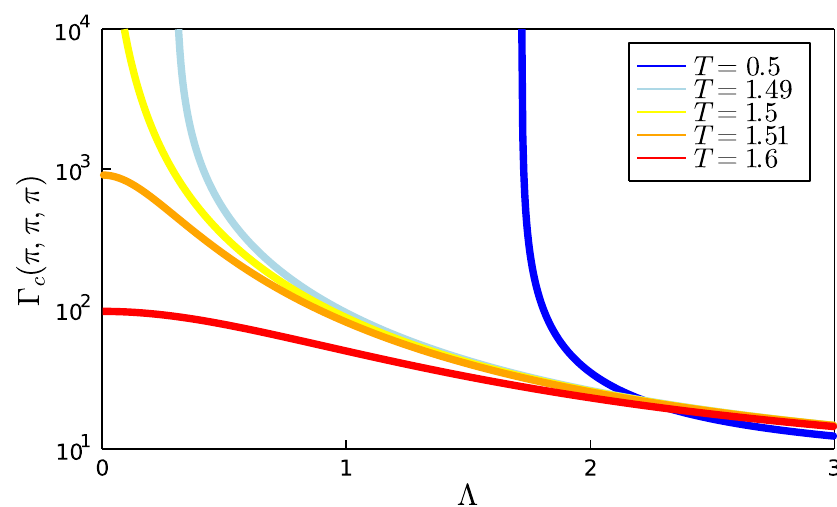
Figure 9: RPA solutions as a function of the cutoff Λ from Eq. (10) for the nearest- neighbor cubic lattice for different temperatures. The solution for the critical temper- = 6 = 1.5 (yellow) diverges exactly at Λ = 0, while at lower temperatures, ature T RPA 4 c the divergence is shifted to finite